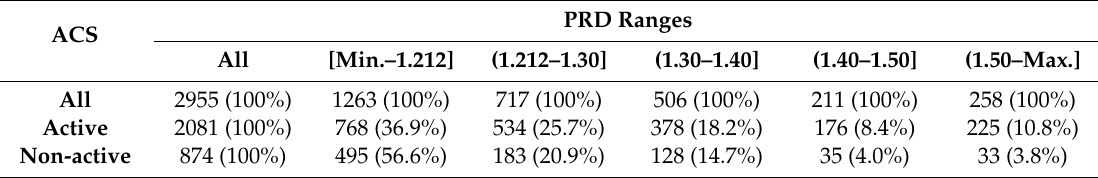
Table 4. Cross-table analysis of ACS by PRD